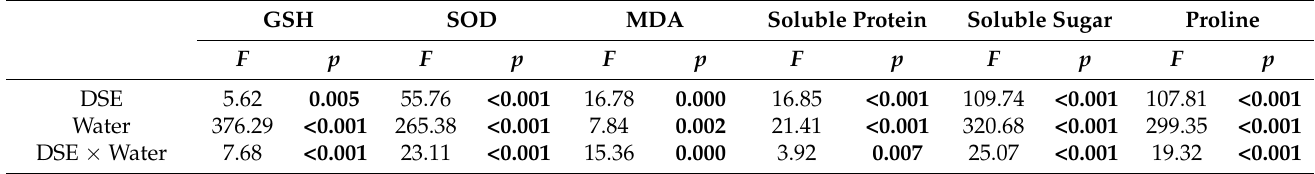
Note: Significant p values ( p < 0.05) are shown in bold. GSH, glutathione content. SOD, superoxide dismutase. MDA, malondialdehyde content.